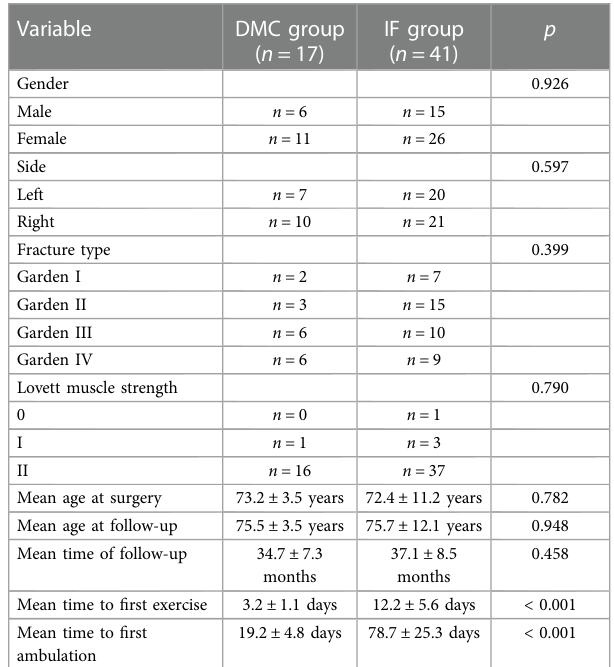
TABLE 1 Baseline characteristics. Values are shown as